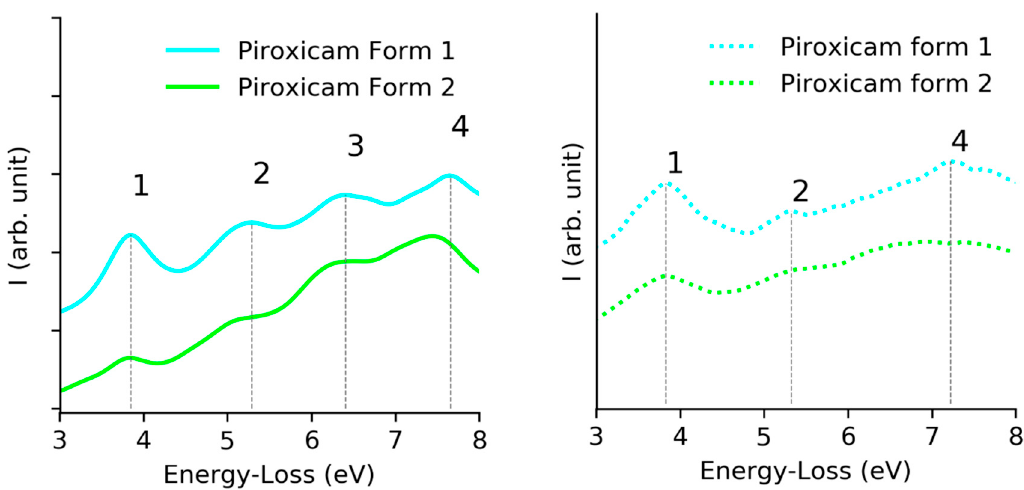
Figure 6. Comparison of the interband transitions observed on theoretical ( left ) and experimental data ( right ) for both forms of piroxicam.